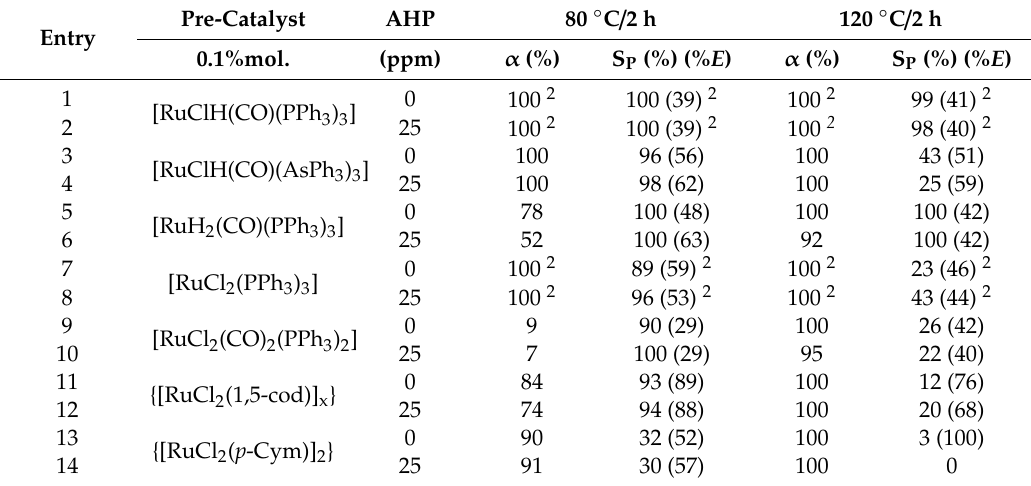
Table 1. The e ff ect of allyl hydroperoxides (AHP) from 4-allyloxybutan-1-ol on the catalytic activity of ruthenium pre-catalyst 1